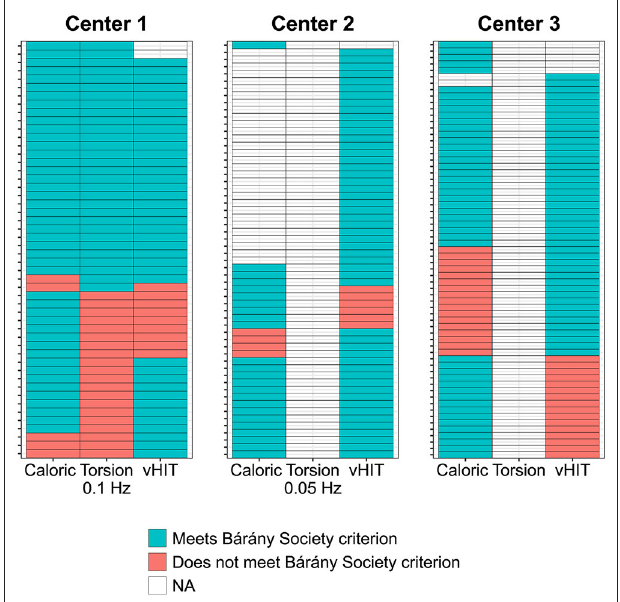
FIGURE 6 | Distribution of patients with BVP meeting the diagnostic criteria of the Bárány Society, presented for each test separately in the color blue (i.e., for the caloric test a reduced response with a sum of bithermal maximal peak slow phase velocity < 6 ◦ /s bilaterally; for the torsion swing test (0.1Hz) an impaired VOR gain < 0.1; for horizontal video Head Impulse Test (vHIT) a bilaterally reduced VOR gain < 0.6). Patients not meeting the diagnostic criteria for each test separately are indicated with the color red. Each column represents one of the diagnostic criteria per center; each row represents one subject per center. NA, no data